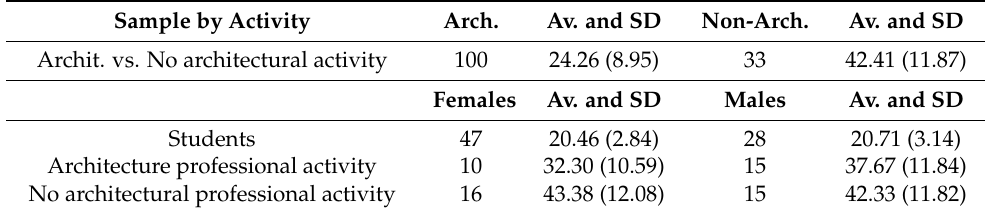
Table 2. Sample data by main activity developed and gender.